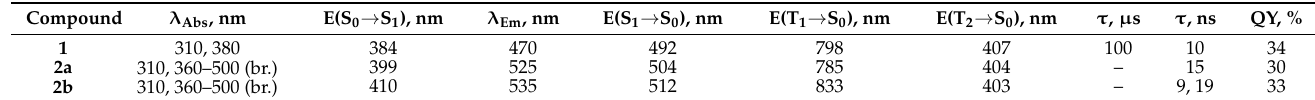
Figure 3. ( a ) Experimental UV-Vis spectra of solid samples 1 – 2 mixed with BaSO4 in the form of Kubelka-Munk functions (lines) and the calculated vertical S 0 – S n transitions and their oscillator strength (TD-PBE0/def2-TZVP(-f)) (vertical bars). ( b ) The corresponding experimental normalized photoluminescence spectra (excitation wavelength 350 nm for 1 and 400 nm for 2a and 2b ). Table 1. Experimental absorption and emission maxima (λ Abs and λ Em ), calculated energies of vertical (S 0 → S 1 ) and emission (S 1 → S 0 , T 1 → S 0 and T 2 → S 0 ) transitions (TD(A)-PBE0/def2-TZVP(-f)), experimental emission lifetimes (τ) , and absolute quantum yield of the emission (QY; at the excitation by 350 nm) for the compounds.